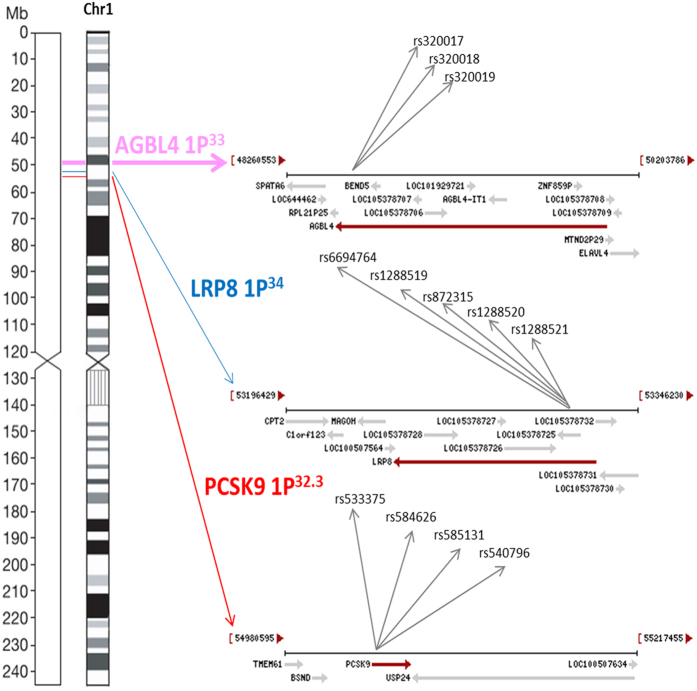
The positions of the AGBL4, LRP8 and PCSK9 mutations.